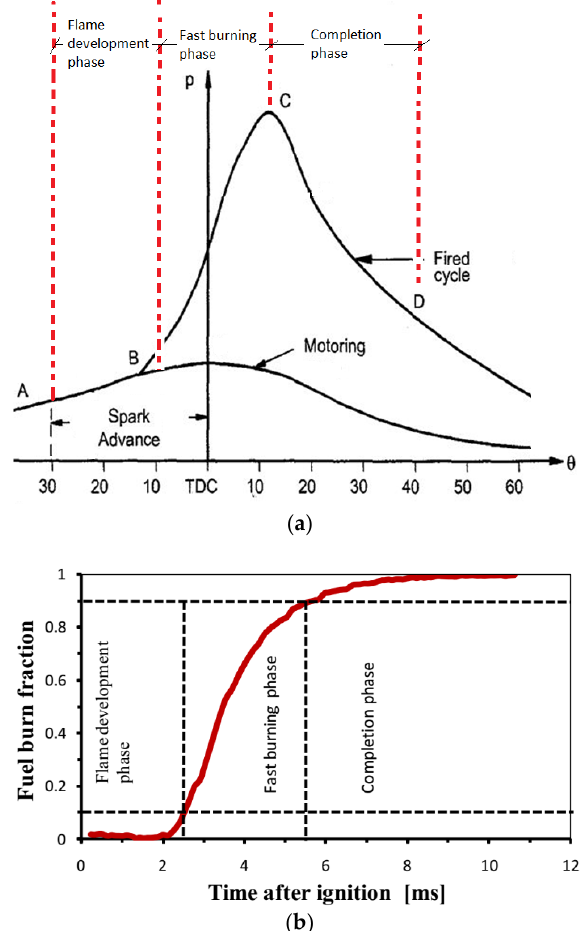
Figure 7. Spark-ignition (SI) engine combustion stages: ( a ) combustion pressure versus crank angle; ( b ) burn fraction of a homogeneous CNG combustion